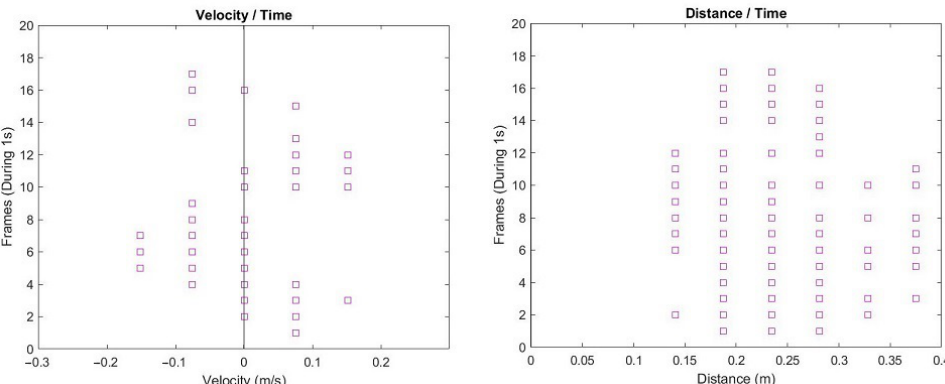
Figure 3. Illustrative visual representations for the data corresponding to one acquisition of the word “Ajuda” (Help): velocity dispersion pattern ( left ) and distance variation ( right ) over 1 second of acquisition frames (along the vertical axis). For this case study, although distance variations were acquired and presented, only the velocity representations were considered for model training and subsequent